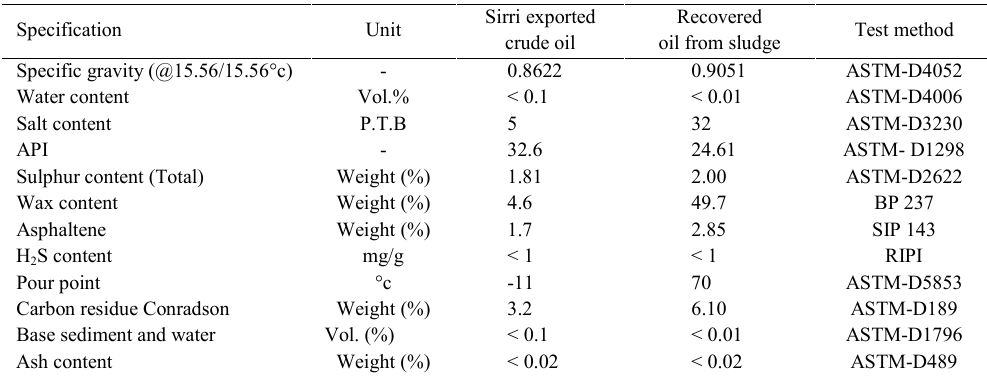
Table 3: Physical and concentrations data for recovered oil, sediment and residue